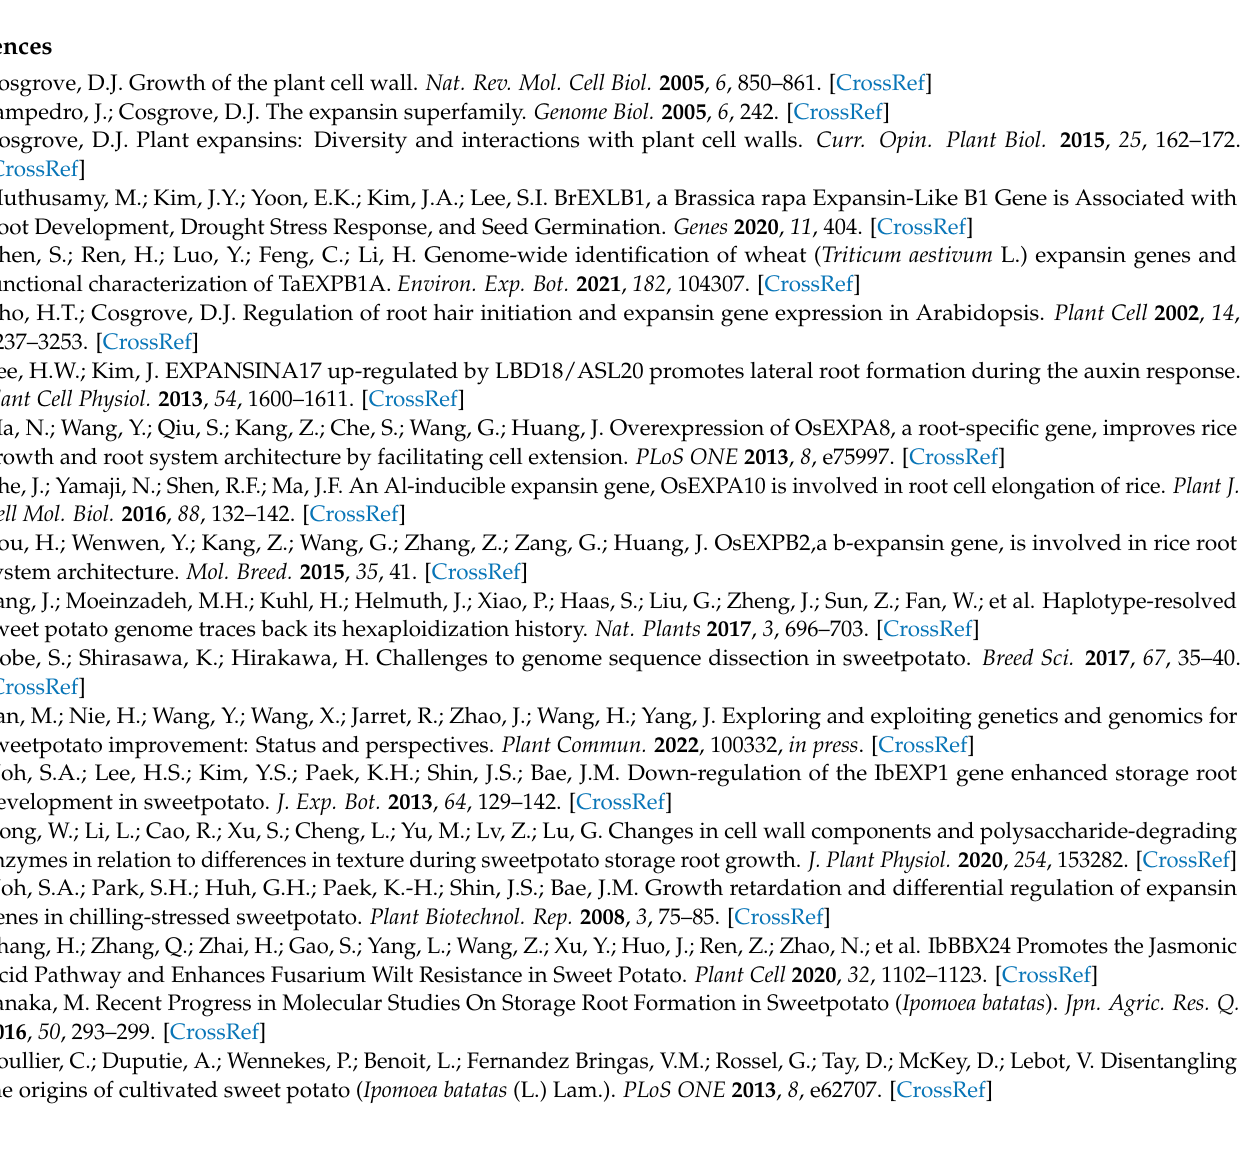
Table S5: The protein sequences of different conserved